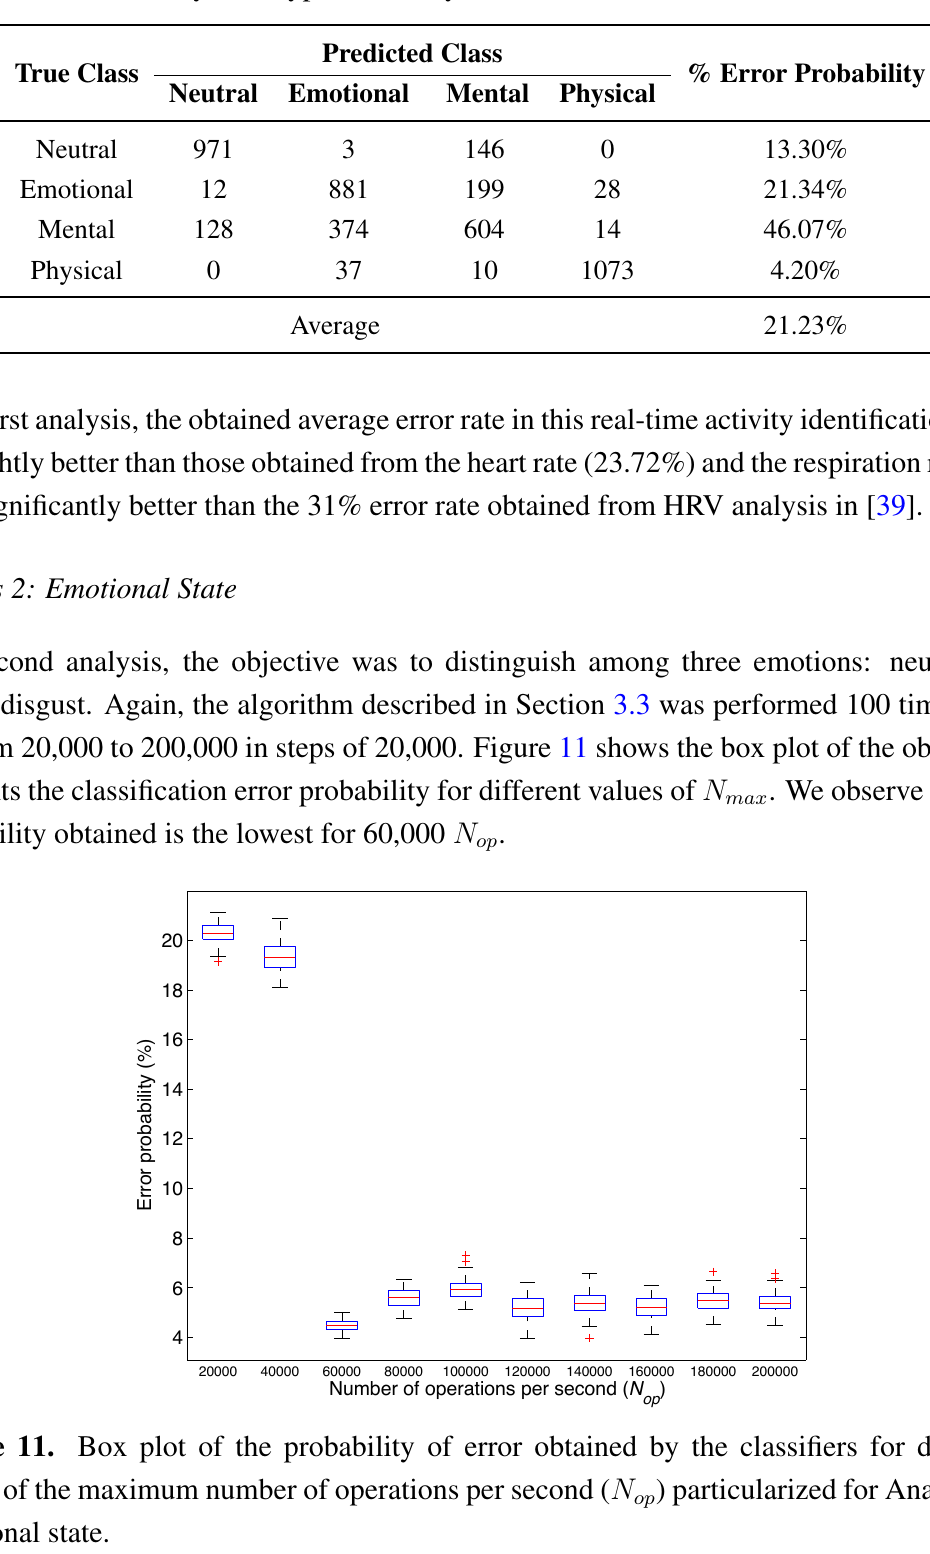
) particularized for Analysis 2: op